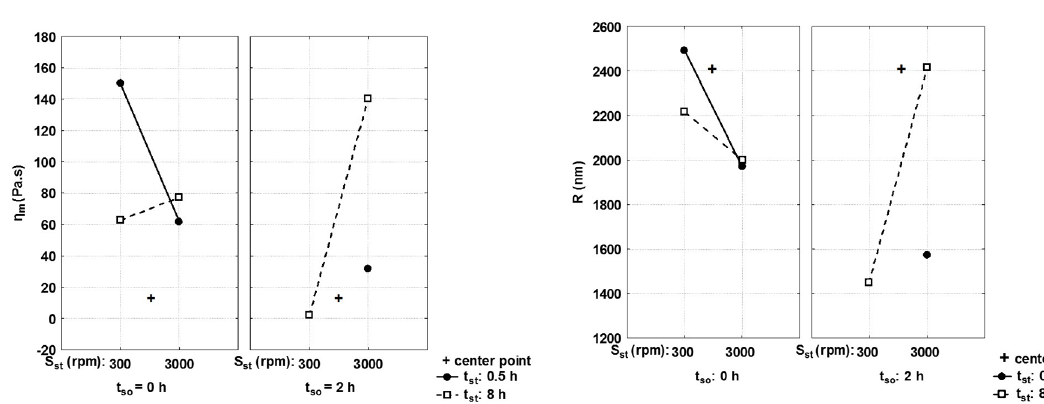
Figure 6. Means plot agglomerate size ( R ). Symbols (+) are related to center point